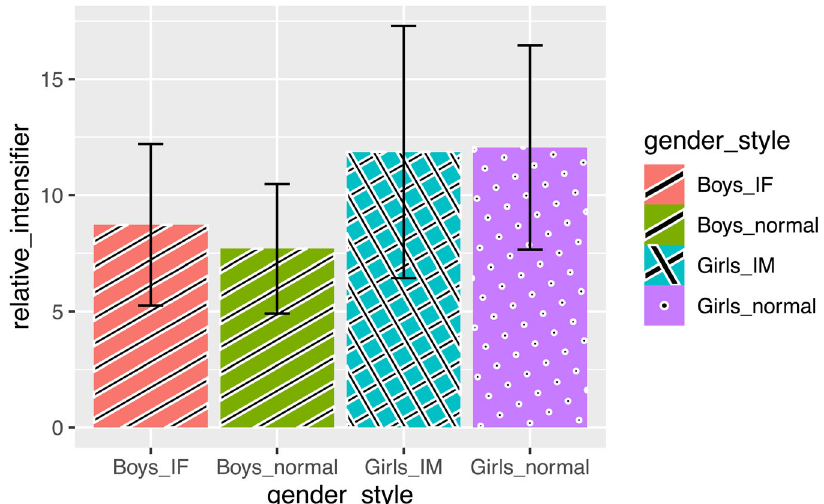
Fig. 3 The mean relative frequency of the use of intensi fi ers in children ’ s compliments. It is demonstrated that the girls used almost equally more intensi fi ers in both their normal speech style and the designed imitating tasks. On the other hand, boys used much fewer intensi fi ers in their normal speech style. They increased using intensi fi ers when intimating girls ’ speech. But the average frequency of the use of intensi fi ers by boys, even after such an increase in the imitating tasks, is still below the level of the frequency of use by